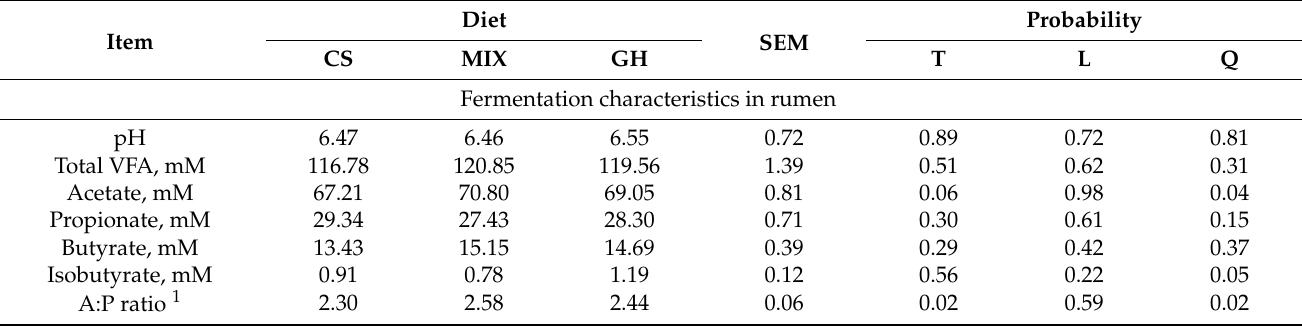
Table 4. Effects of different forage sources on the ruminal and duodenal fermentation characteristics of